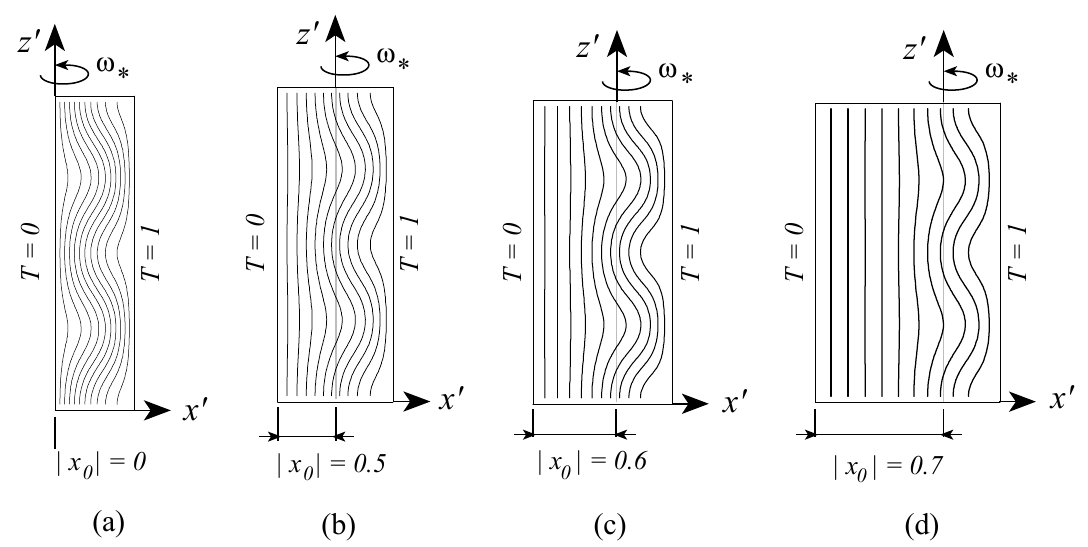
Figure 11. The convective flow field at marginal stability for two different values of x streamlines equally divided between ψ = 0.8 at x ; ( b ) streamlines for the axis of rotation located at x 0 permission from Elsevier Science Ltd.)